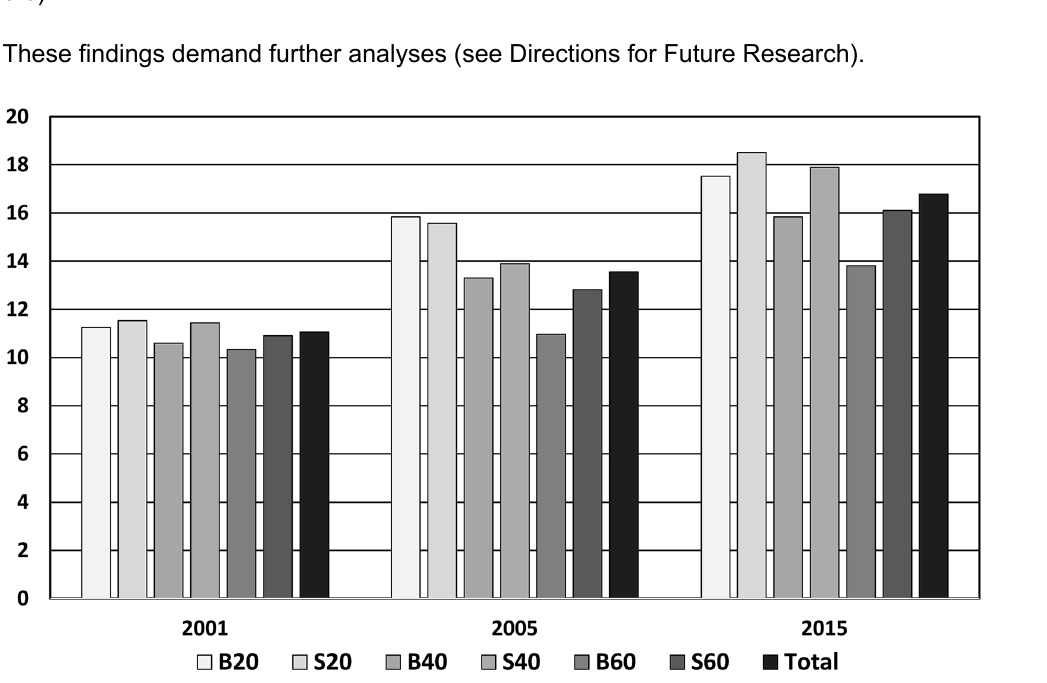
In 1991, 95.1% of the respondents had never used the Internet, but in 2015 the proportion of daily users was 74.5%. Despite the above, traditional media – newspapers, magazines, TV, and radio – still had an important